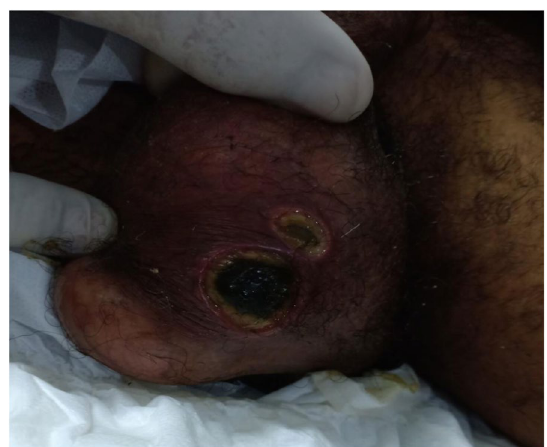
Fig. 1 Ecthyma gangrenosum: two scrotal ulcers with central necrosis (black gangrenous